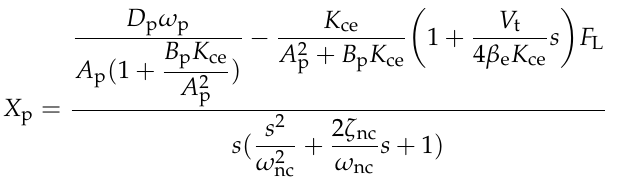
Figure 13. Position loop simplified control diagram.